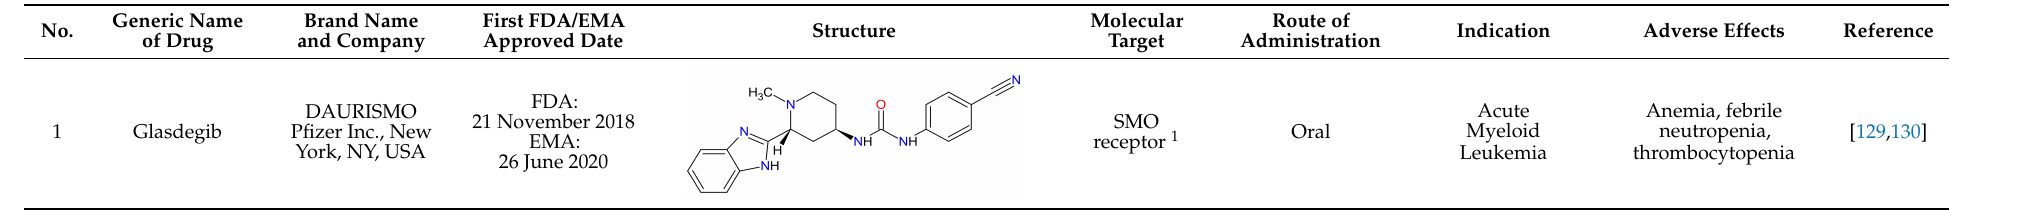
Table 5. Features of the various receptor antagonists approved by the Food and Drug Administration (FDA) from 2011 to 2021.